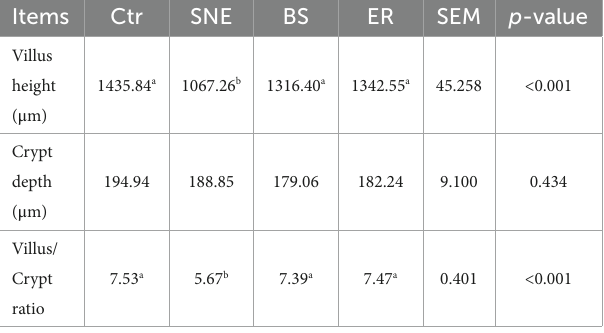
TABLE 4 The jejunum histomorphology of broilers infected with Clostridium perfringens . Items